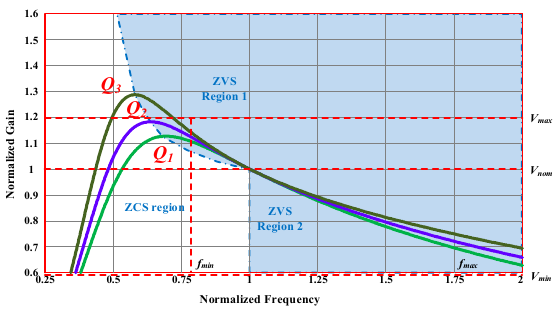
Figure 1 . Gain analysis of a typical LLC resonant converter. Figure 1. Gain analysis of a typical LLC resonant